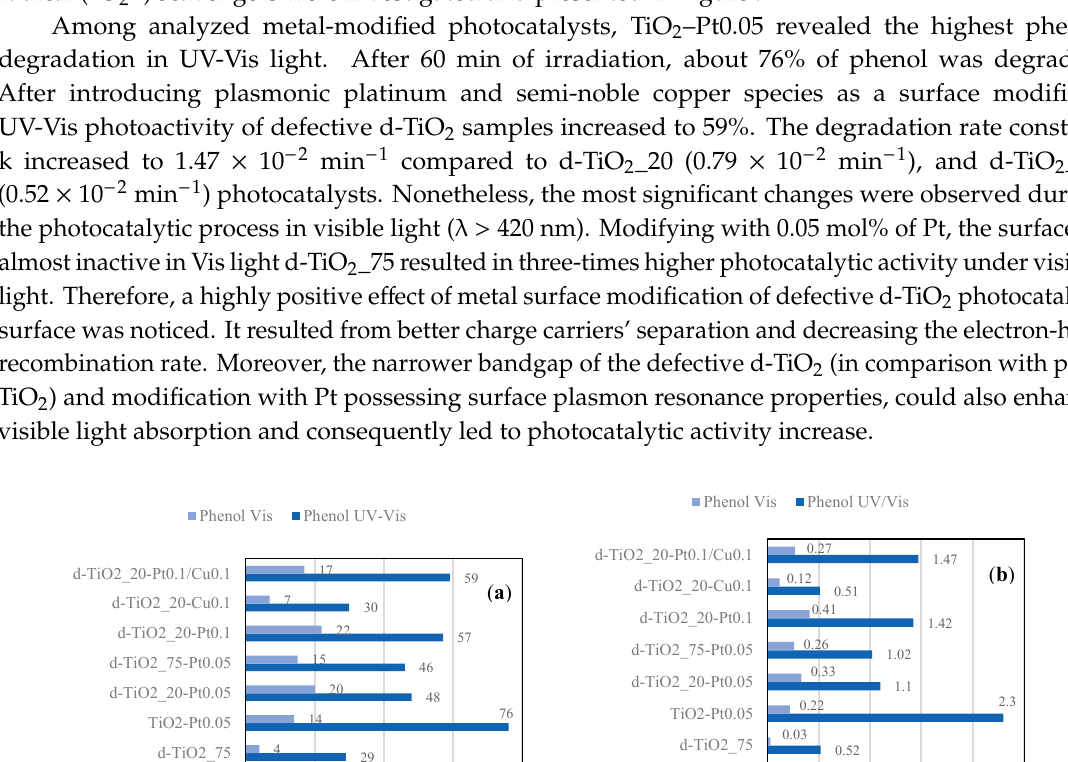
Figure 6. Transmission electron microscopy (TEM) analysis for Fe 3 O 4 @SiO 2 / d-TiO 2 _20 / Pt0.1 sample ( a ) magnification on Pt nanoparticle ( b ).